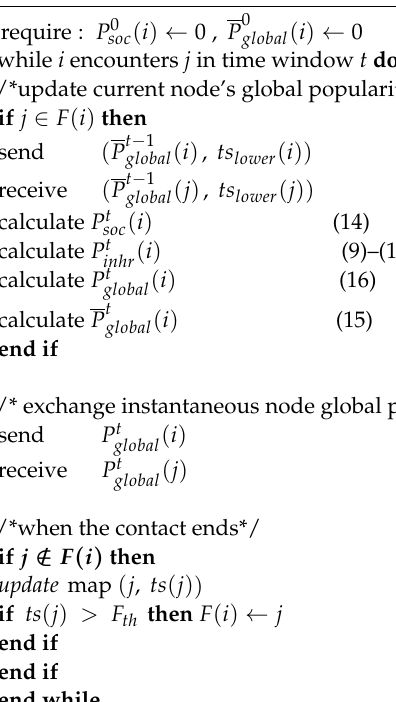
Algorithm 1: TraLDA node global popularity calculation ( i